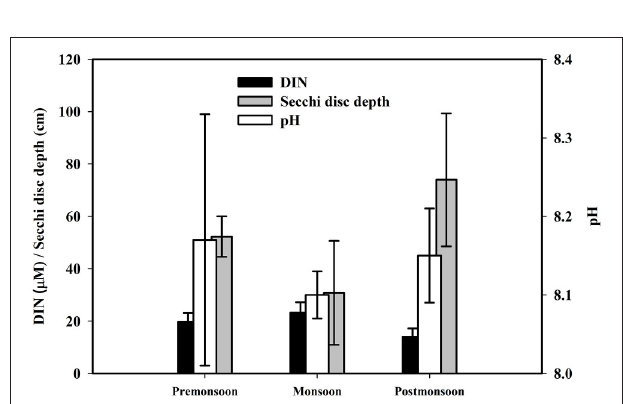
FIGURE 7 | Seasonal variations of mangrove surface sediment CH 4 oxidation and CH 4 emission (F SA ) across mangrove sediment-atmosphere interface of Lothian Island.